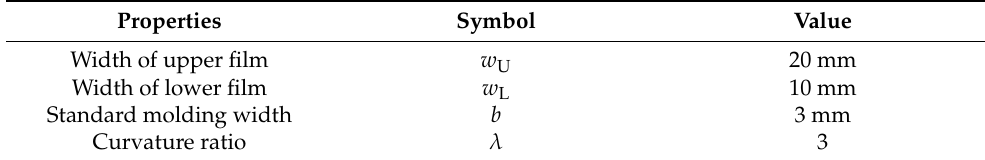
( b ) Fabricated mold Figure 7. Three-dimensional drawing and photograph of duralumin mold for PI film molding: ( a ) 3D model of mold; ( b ) photograph of fabricated mold.